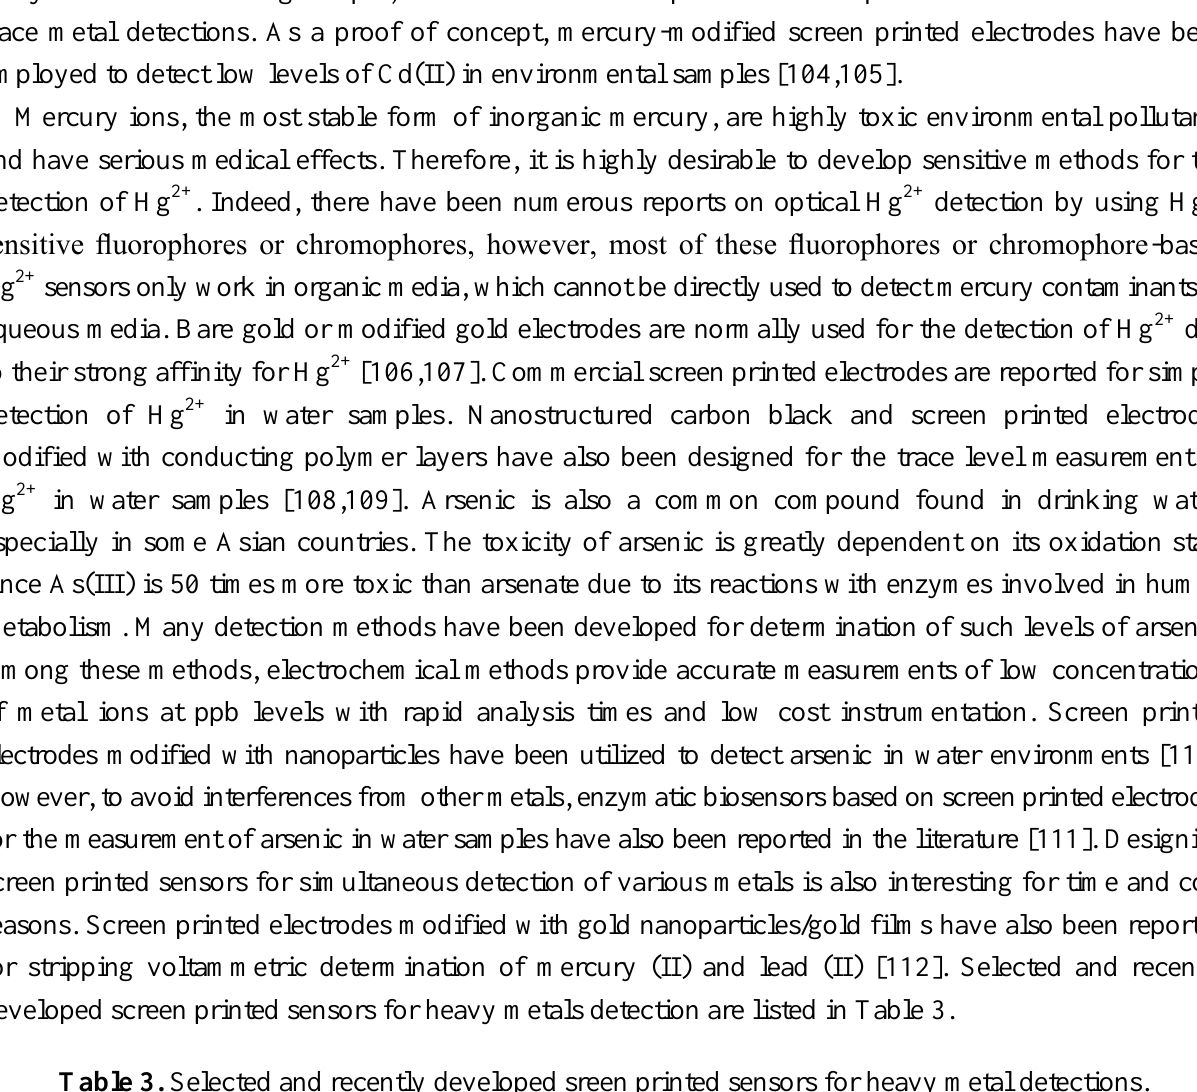
Table 3. Selected and recently developed sreen printed sensors for heavy metal detections. Analyte Modifier Detection Method